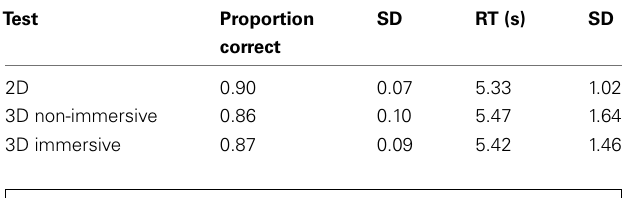
Table 1 | Descriptive statistics for three versions of the MR test in 2DNI, 3DNI, and 3DI.